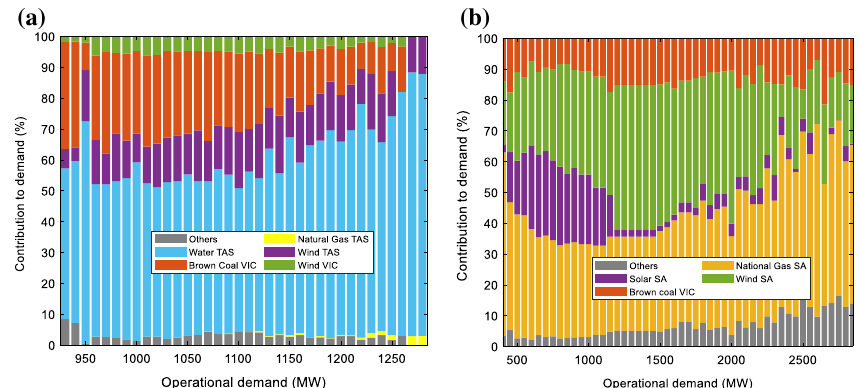
Fig. 7 Contributions of the different types of generators to operational demand in a TAS and b SA